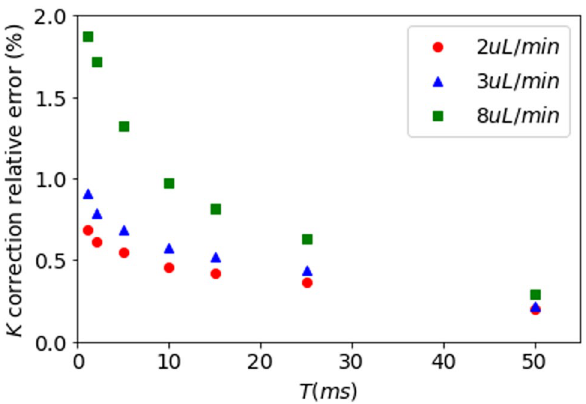
Figure 4. Relative error on contrast calculation due to noises contribution as a function of exposure time for different flows of intralipid-2% in a 300 µm diameter channel. Data have been acquired in synthetic exposure, with frames of 1 ms exposure time, and under optimal illumination using the full dynamic of the camera sensor.